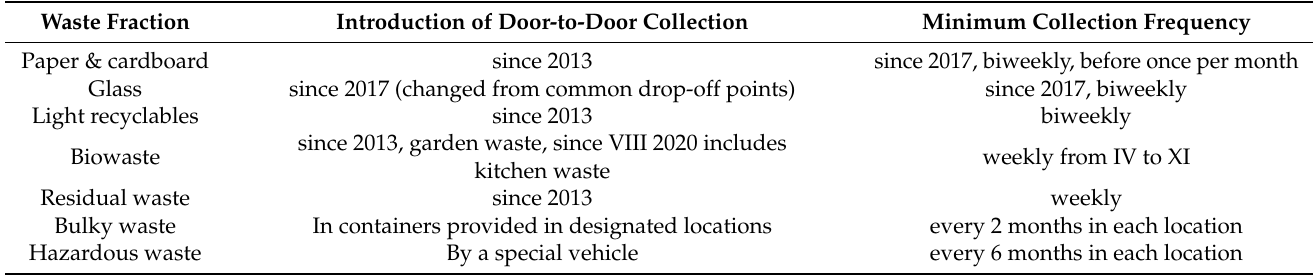
Table 1. Door-to-door municipal waste collection scheme in the city of Wrocław.